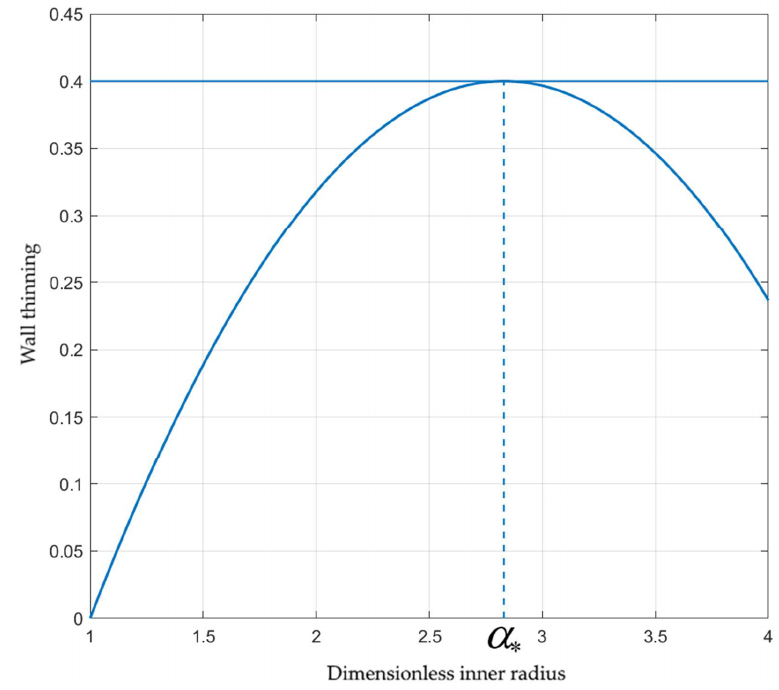
Figure 7. Geometric illustration of the special solution to Equation (48).